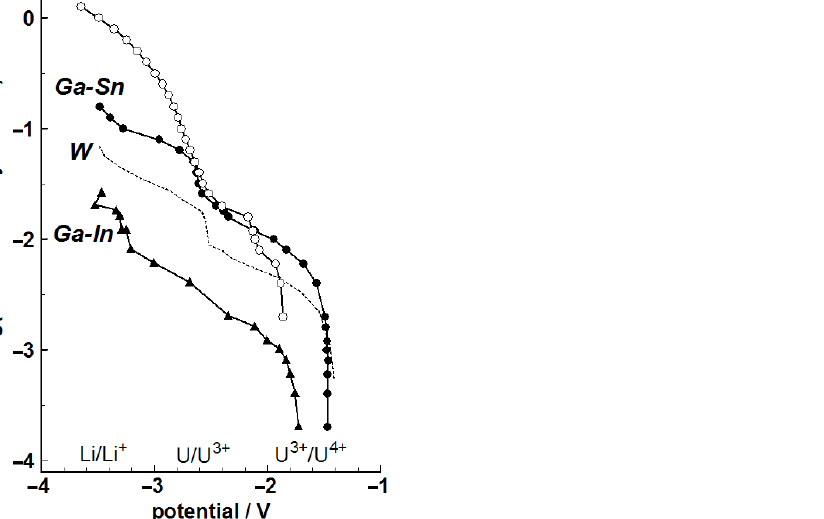
Figure 8. Polarization of liquid Ga–Zn alloy cathode in 3LiCl–2KCl–ZrCl 4 –UCl 4 melt at 534 °C (1.64 wt. % ZrCl 4 , 2.03 wt. % UCl 4 ). Potentials vs. 2Cl − /Cl 2 reference couple. Processes of separating two metals by selective cathodic reduction or by an ex- change red-ox reaction (e.g., reductive extraction) are of the same nature. Therefore the maximum possible (thermodynamically achievable) effectiveness of a separation process can be deduced applying any of these approaches. Here, to estimate the effectiveness of a separation process for uranium and zirconium using a given “molten salt—liquid metal”